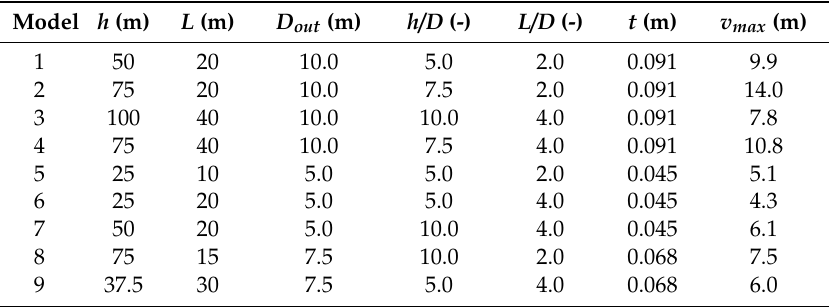
Table 3. Calibration space for validation